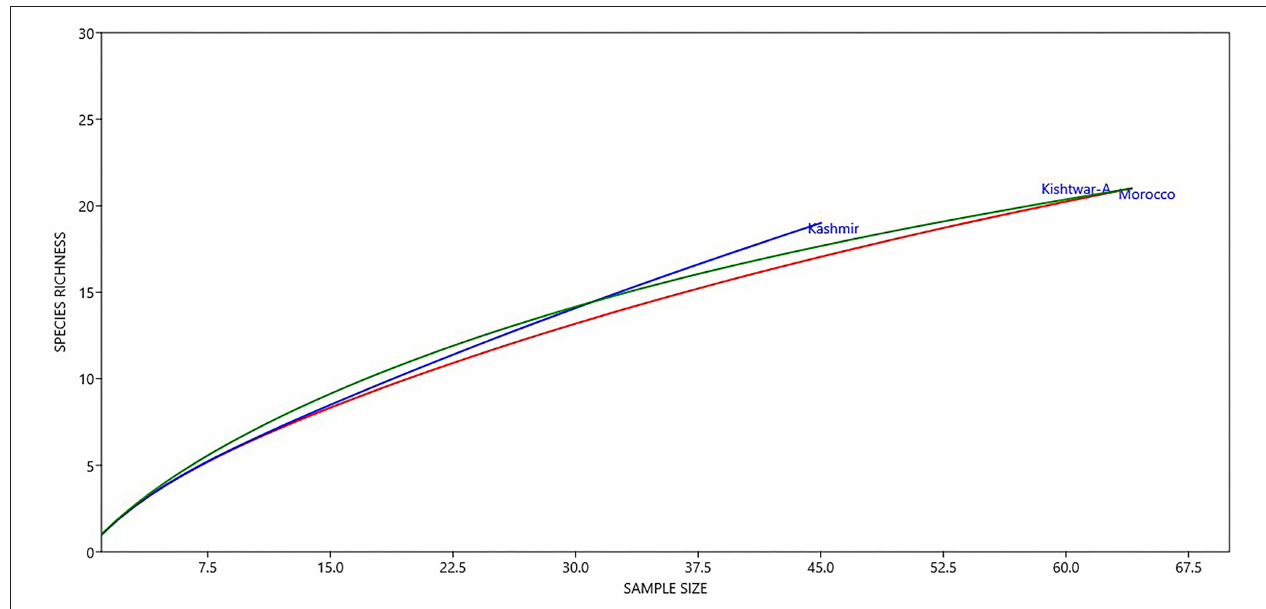
FIGURE 12 | Diversity of different genera across geographical locations (Kishtwar-A, Kashmir, and Morocco). Kashmir samples were more enriched as depicted by higher number of species in Kashmir followed by Kishtwar-A and